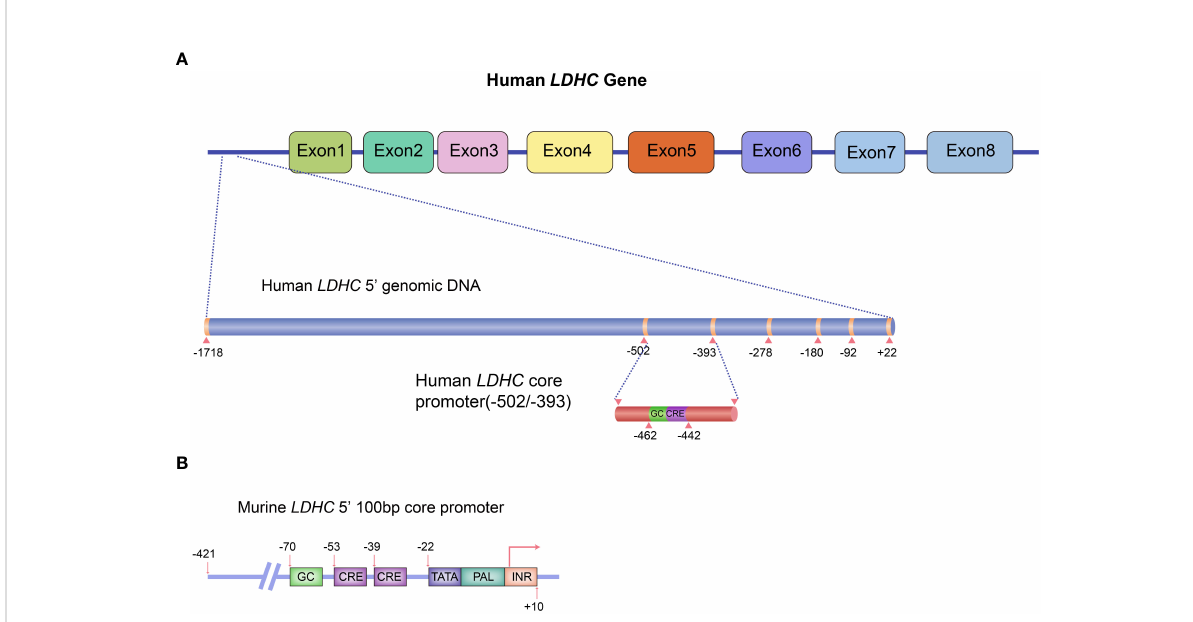
FIGURE 1 Schematic diagram of LDHC gene structure and the regulatory elements for gene expression. (A) Human LDHC gene structure and its cis- regulatory elements and known trans-acting transcriptional regulators. (B) The 100-bp core promoter murine LDHC and its elements. The schematic diagram was plotted in line with the published studies (17,